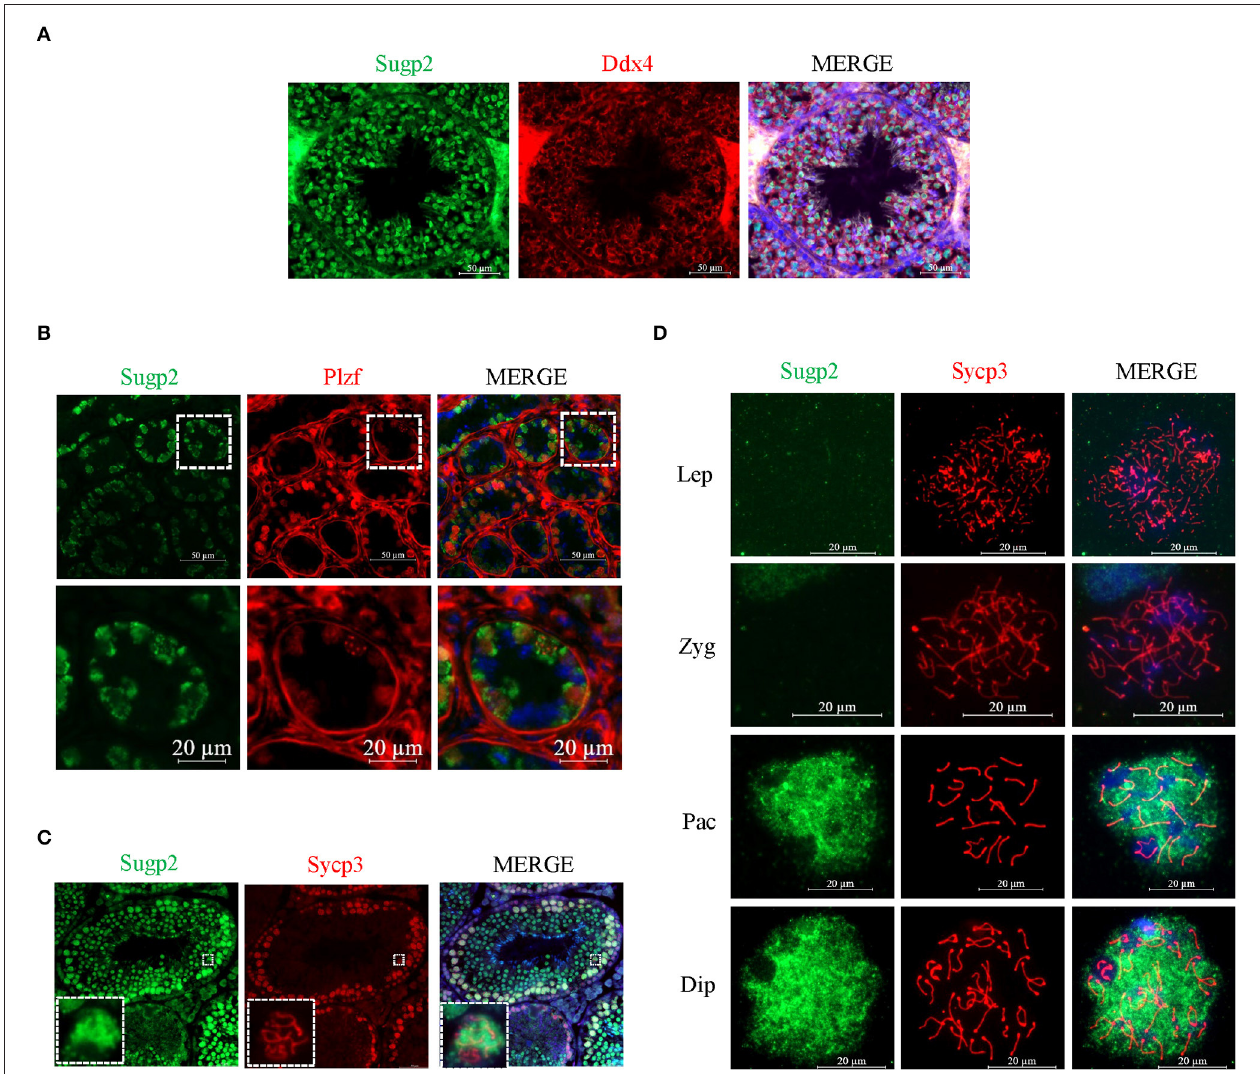
FIGURE 3 | Localization of Sugp2 in mouse testis. Frozen sections of adult (A,C) and PD6 (B) testes were co-stained with rabbit anti-Sugp2 and mouse anti-Ddx4 (A) , Plzf (B) , or Sycp3 (C) antibodies. Ddx4, Plzf, and Sycp3 were used as germ cells, spermatogonia, and spermatocyte markers, respectively. The DNA was stained with DAPI. Scale bar = 20 µ m. (D) Distribution pattern of Sugp2 on the chromatin of spermatocytes from leptotene through diplotene stages.